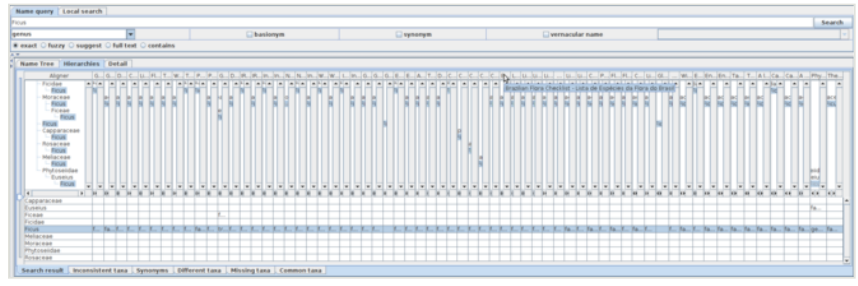
Comparison of Ficus usages as hierarchies up to family, without lower name usages. 65 hierarchies from separate data sources are shown with pop-up window revealing the name of data source where the cursor is placed on. Capparaceae is included as a side e ff ect of synonymisation of a Ficus species to a Capparis species. Phytoseiidae is included as an artefact of treating the description of specimen where the name was obtained. Rosaceae and Meliaceae are included in only one data source, and hence there are two families containing Ficus , each for animal and plants.